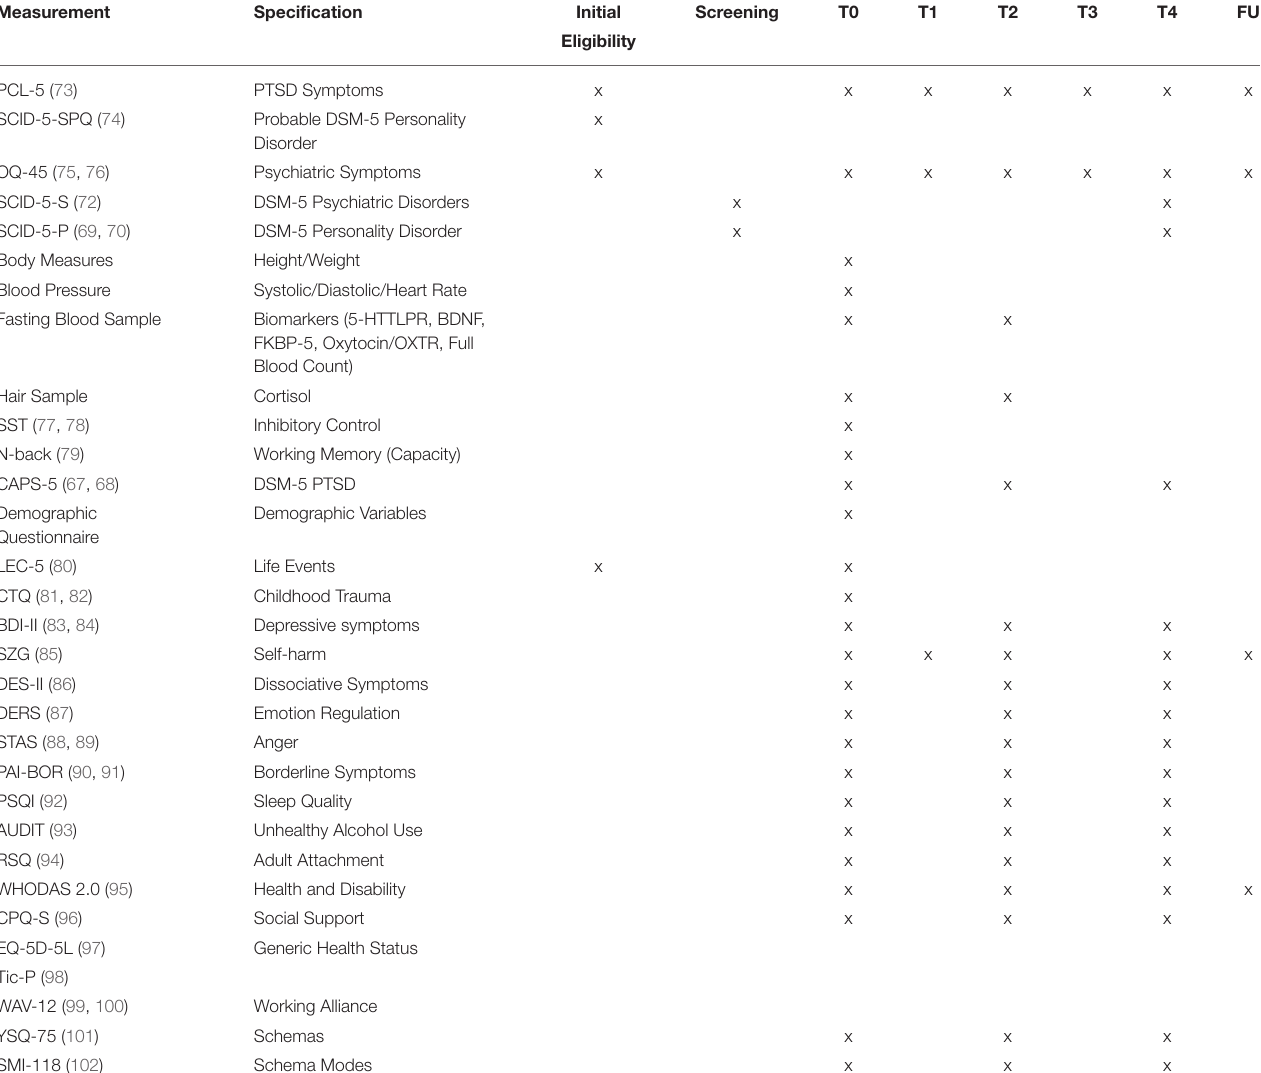
TABLE 1 | Comprehensive list of measurements and time points.